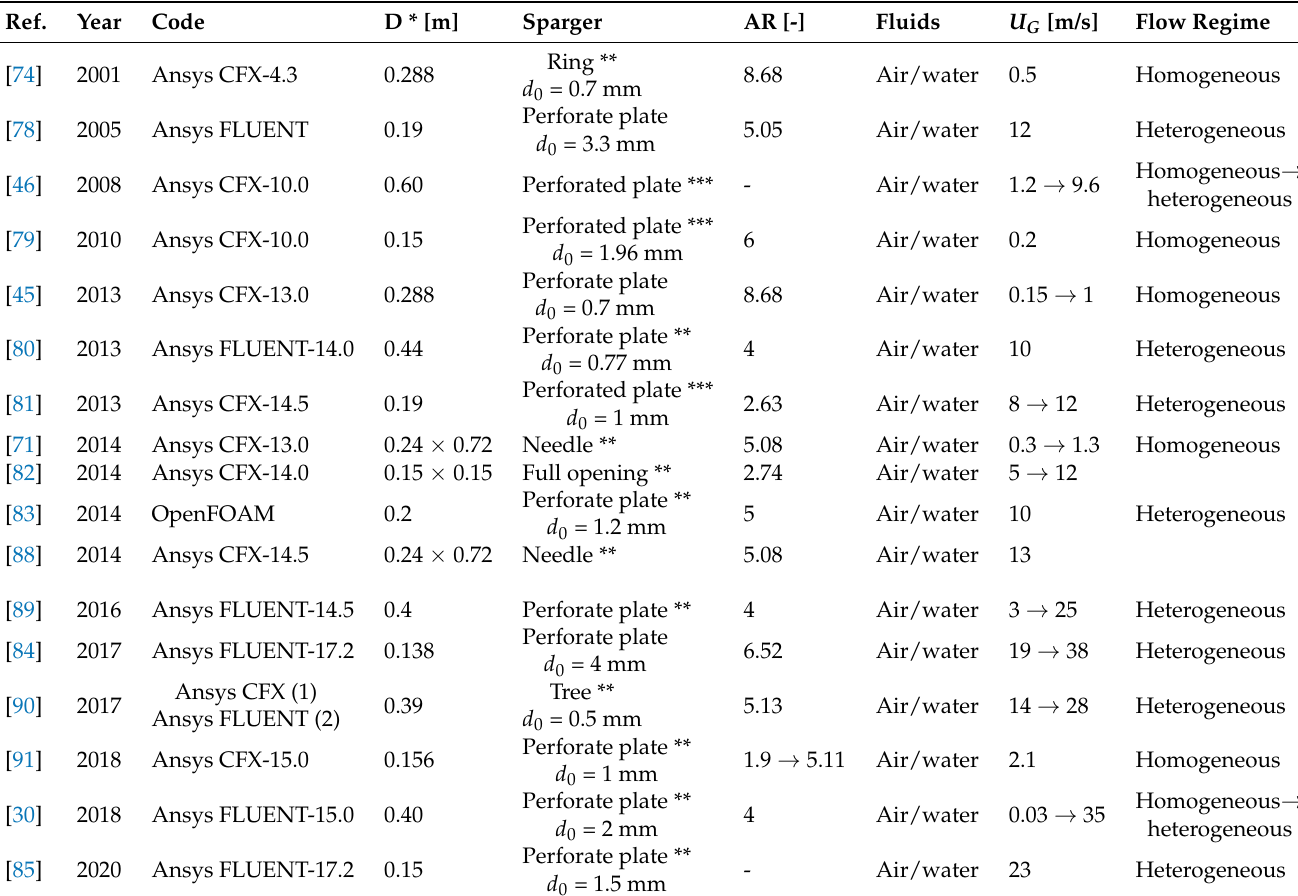
Table 5. Literature survey: column characteristics and operating conditions.